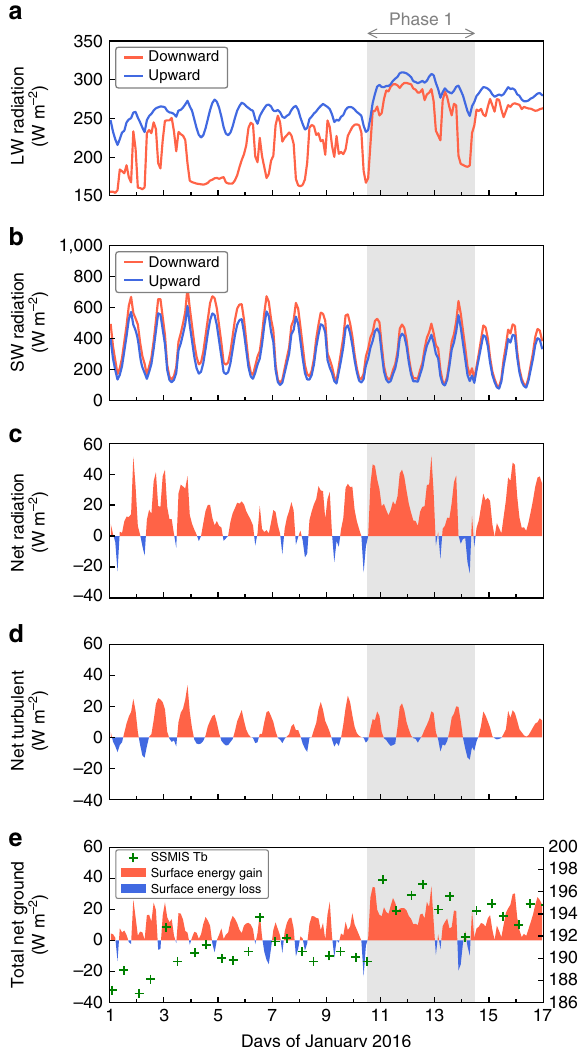
Figure 4 | Surface energy budget at WAIS Divide in January 2016. ( a ) Downward (LW k ) and upward (LW m ) longwave radiation fluxes. ( b ) Downward (LW k ) and upward (LW m ) shortwave radiation fluxes. ( c ) Net radiation flux (LW k – LW m þ SW k – SW m ). ( d ) Net turbulent flux, calculated as the sum of sensible (SHF) and latent (LHF) fluxes, where positive is energy transfer away from the surface to the atmosphere. ( e ) Total net energy flux into the ground (snowpack) calculated as net radiation minus net turbulent fluxes. The green crosses represent the SSMIS 19GHz horizontally polarized brightness temperatures measured from space at the location of WAIS